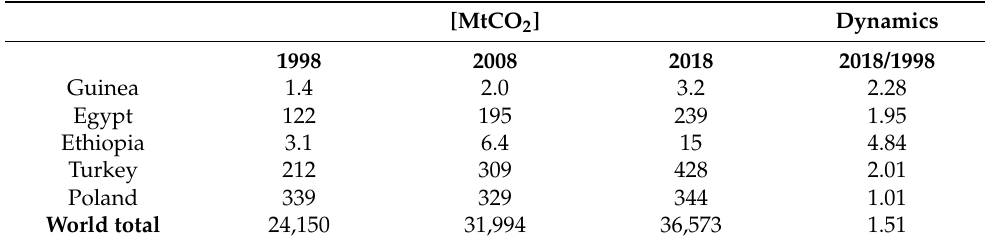
Table 3. CO 2 Emission and Dynamic of Emission Growth.